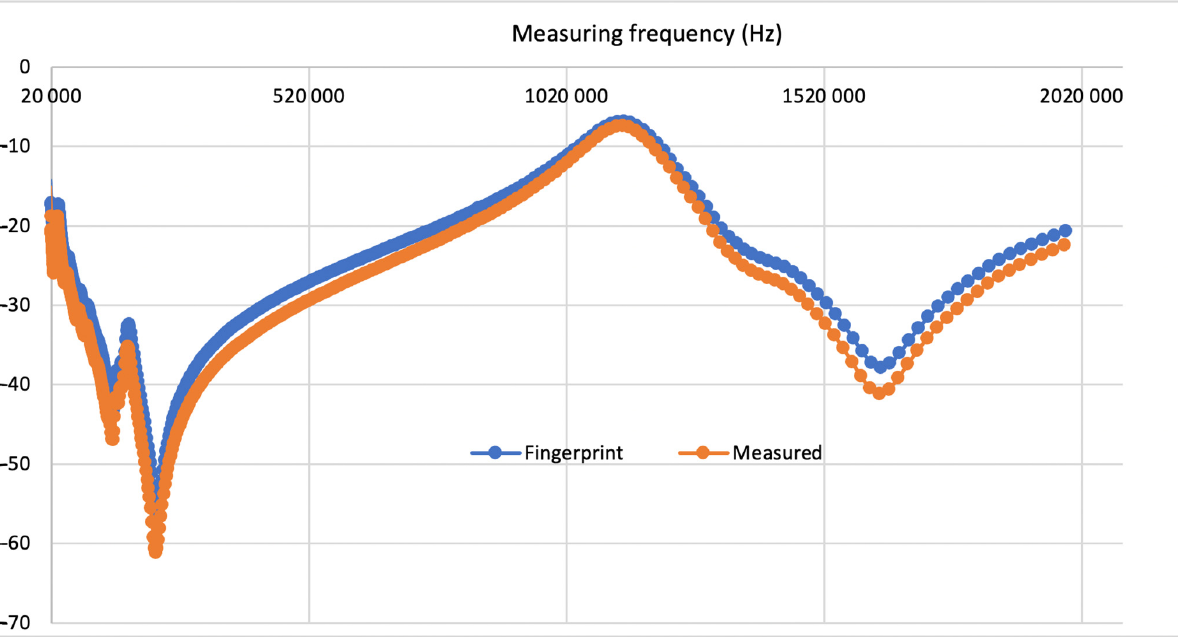
Table 12. Case study 3 ANOVA results.